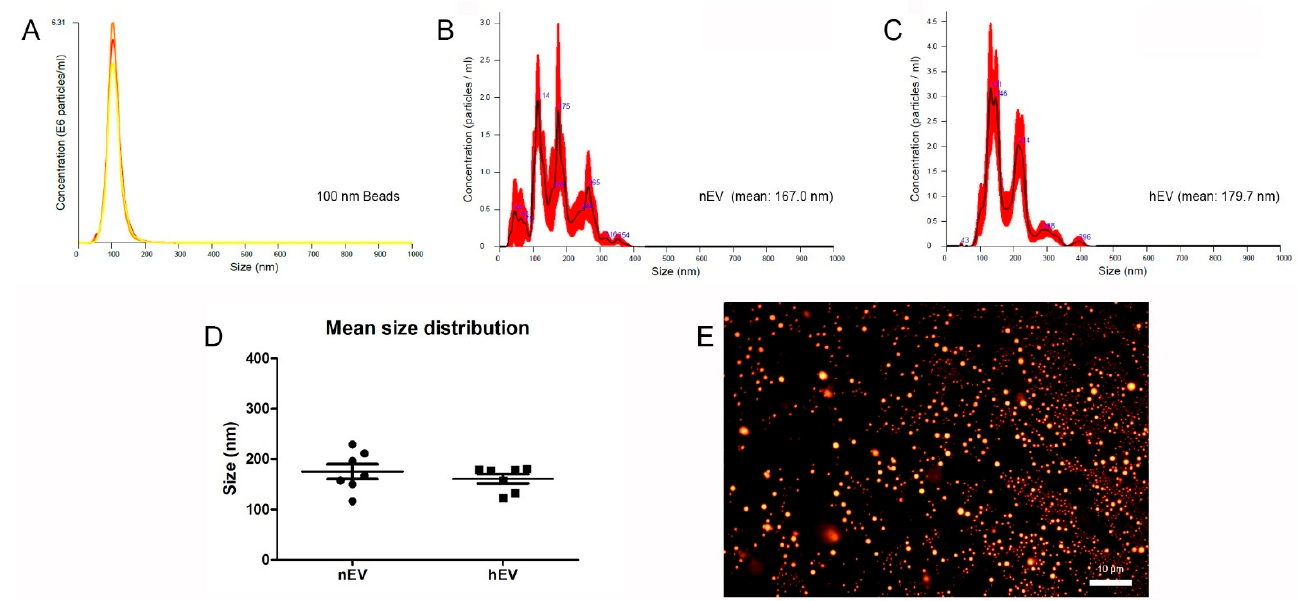
Figure 2. Characterization of extracellular vesicles isolated from adipose-derived mesenchymal stromal/stem cells (ASCs). ( A ) Characteristic nanoparticle tracking analysis of 100 nm Beads. ( B , C ) Representative nanoparticle tracking analyses (NTA) of EVs isolated from ASCs after culture in a normoxic ( B ) or hypoxic ( C ) environment for 48 h. ( D ) Calculated mean size distribution of isolated EVs measured by NTA using a NanoSight NS500 ( n = 7 for nEVs and hEVs). No significant differences were detected. ( E ) PKH26 staining of SEC-isolated EVs. Fluorescence microscopy shows PKH26-labeled EVs on an adhesion slide (scale bar = 10 μ m).